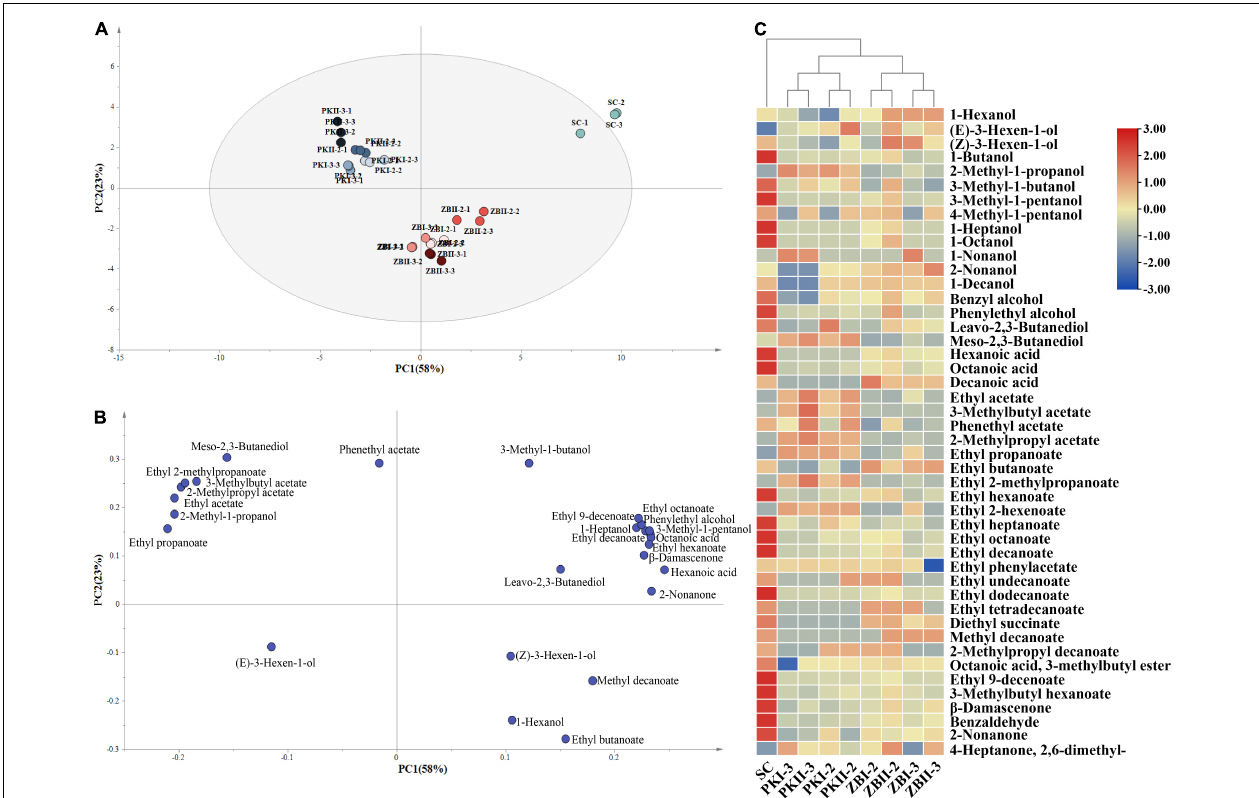
FIGURE 3 | Principal component analysis (PCA) and hierarchical cluster analysis (HCA) of wine volatile components in different fermentations. (A,B) Principal component analysis (PCA) biplots of wines resulting from 26 volatile compounds (OAV above 0.1) by different fermentation methods after alcoholic fermentation. (C) Hierarchical clustering and heatmap visualization of volatile compounds of wine samples in different